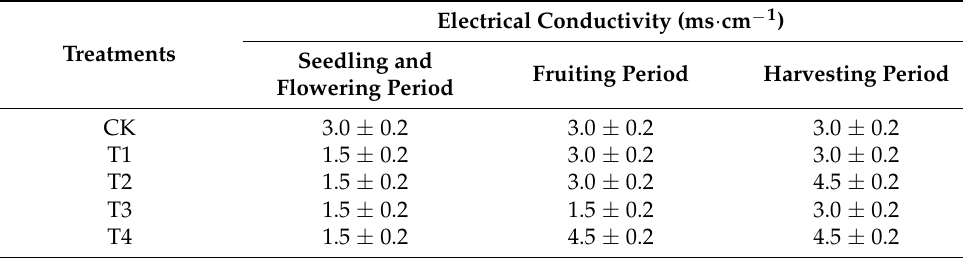
Table 1. Different concentrations of nutrient solutions based on different growth periods.